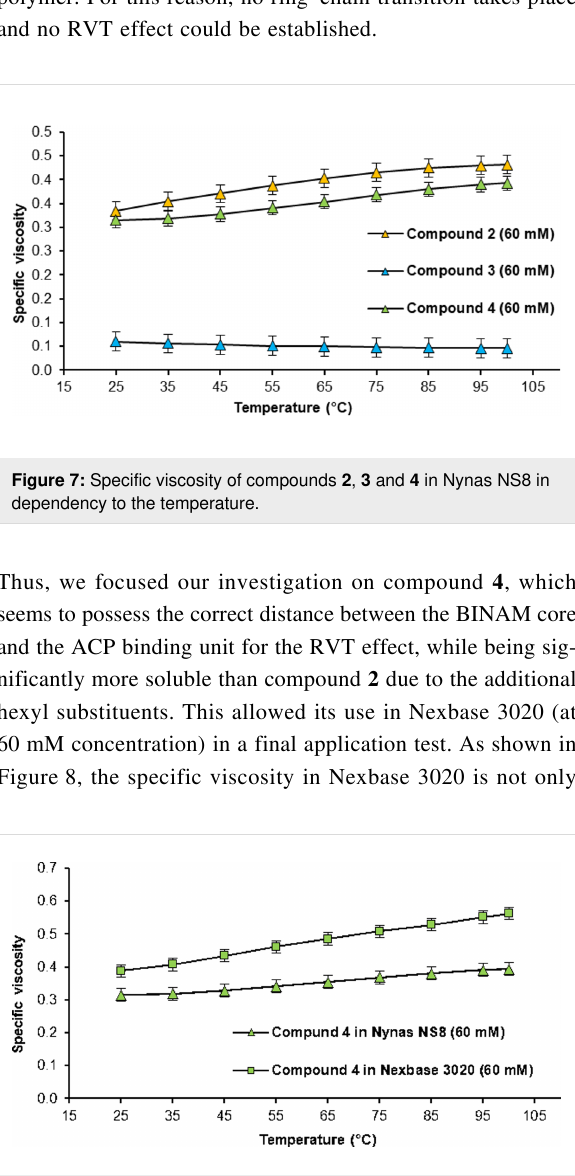
Starting with the measurements in Nynas NS8, compounds 2 , 3 and 4 were tested at 60 mM concentration. Compounds 2 and 4 behave in a very similar fashion and show an increase in specif- ic viscosity over the entire temperature range (25–100 °C). In strong contrast, compound 3 does not show an RVT effect and the specific viscosity decreases significantly upon increasing the temperature (the same was also observed in toluene solu- tion, see Supporting Information File 1, chapter 6.3.2). Thus, the modification of the linking unit by insertion of one amino acid (to give compound 3 ) has a detrimental effect on the RVT effect (Figure 7). Most likely, extension of the linker-unit tips the balance between cyclic monomers and the supramolecular polymer. For this reason, no ring–chain transition takes place and no RVT effect could be established.